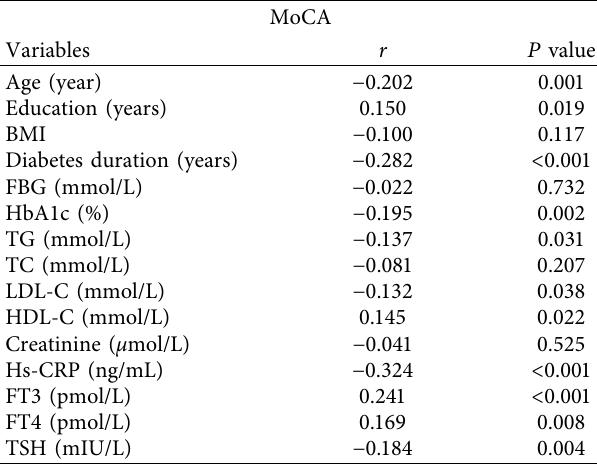
Table 2: The correlations of MoCA score with clinical indicators in T2DM